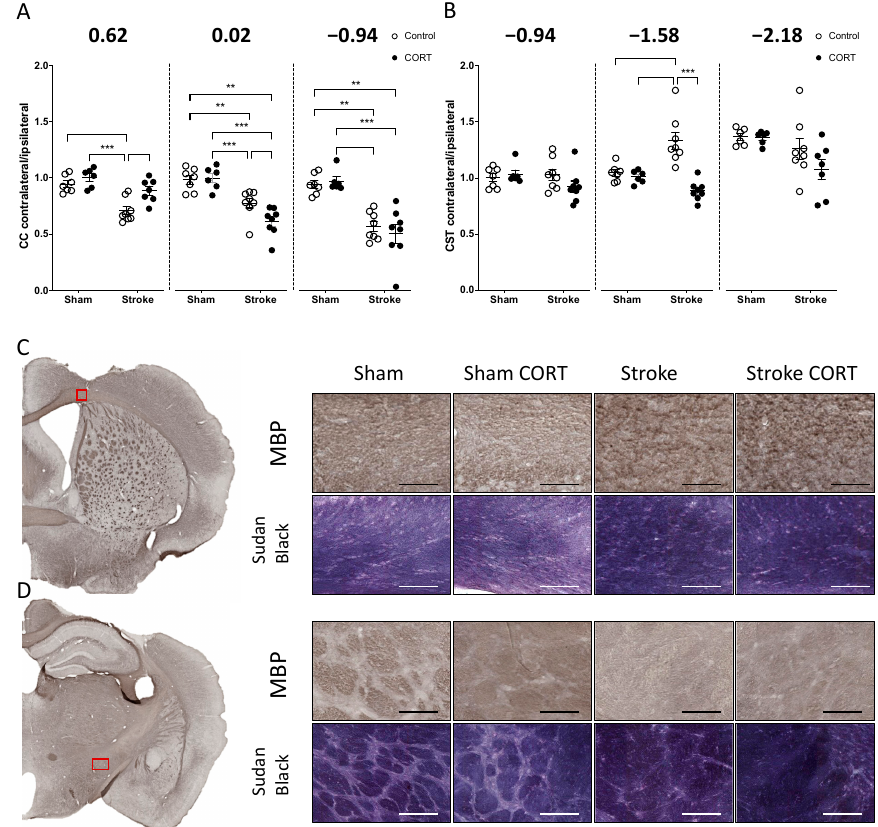
Figure 2. Changes in myelin structure after stroke and corticosterone (CORT) administration. Graphs showing the ratio of contralateral to ipsilateral volume of ( A ) the corpus callosum (CC) and ( B ) the corticospinal tract (CST) at 3 different Bregma levels. Representative immunohistochemical staining of myelin basic protein (MBP) in ( C ) the CC and ( D ) CST of the stroke affected hemisphere. The red squares represent the white matter regions used for analysis. The right panels show MBP and Sudan Black staining from the cropped regions across the four different groups. Scale bar in CC panels = 75 µ m for MBP and 100 µ m for Sudan Black. Scale bar in the CST panels = 100 µ m for MBP and 150 µ m for Sudan Black. Data on the graphs are expressed as mean ± SEM *** p < 0.001, ** p < 0.01.